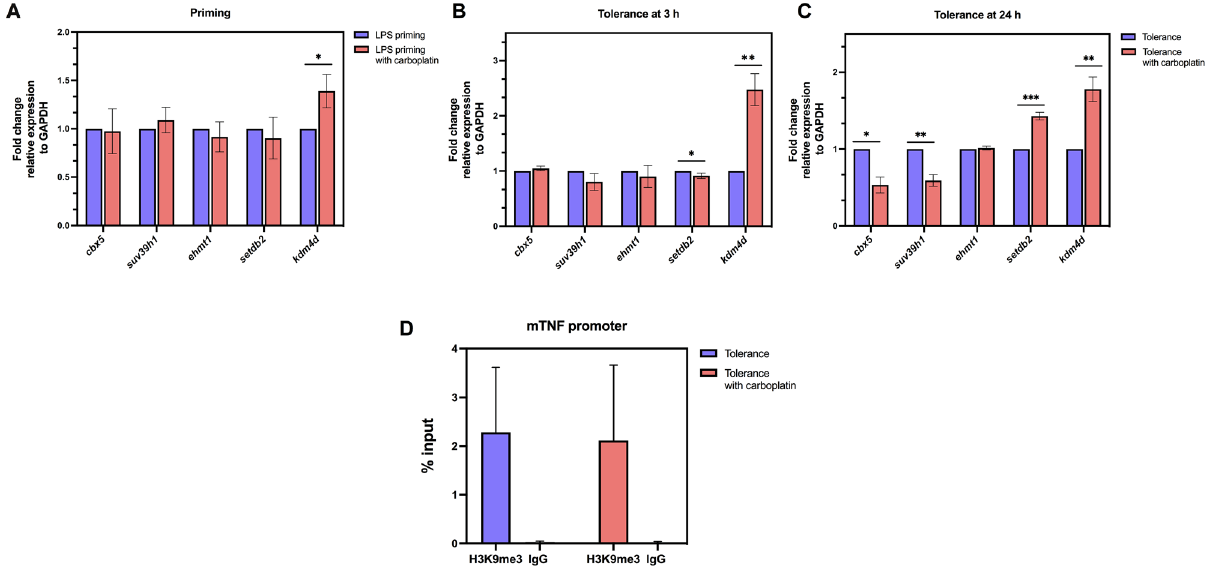
Figure 6. Effects of carboplatin on the expression of genes encoding H3K9-modifying enzymes. ( A , B ) BMDMs were primed and challenged with LPS as described. The relative expression of the following genes encoding H3K9-modifying enzymes was quantified by RT-qPCR: the HP1-α encoding gene cbx5; methyltransferase enzyme coding genes suv39h1, ehmt1, and setdb2; and the demethylase enzyme encoding gene kdm4d . ( A ) LPS- primed BMDMs and ( B , C ) LPS-tolerant BMDMs at 3 h or 24 h. Transcript levels are expressed relative to the untreated control after normalization to the housekeeping gene gapdh. Experiments were performed in at least 2 biological replicates. *, **, ***, **** indicate p < 0.05, p < 0.01, p < 0.001, p < 0.0001, respectively, using one-way ANOVA. ( D ) ChIP-qPCR of H3K9me3-associated DNA spanning the tnf-α promoter. BMDMs were treated as indicated with or without carboplatin. Cells were fixed and prepared according to the SimpleChIP ® Enzymatic Chromatin IP kit. The promoter enrichment quantification was normalized to a 2% input. Rabbit anti-IgG antibody was used as negative control. The assay was conducted in 3 biological